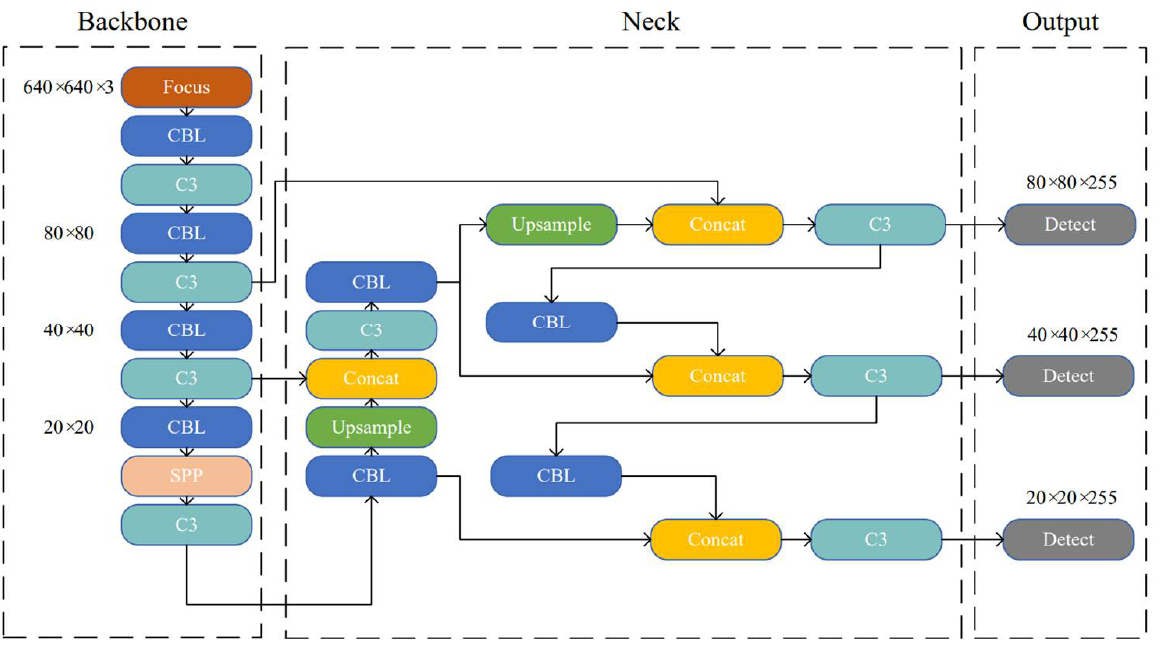
Figure 3. The network structure of the original YOLOv5.